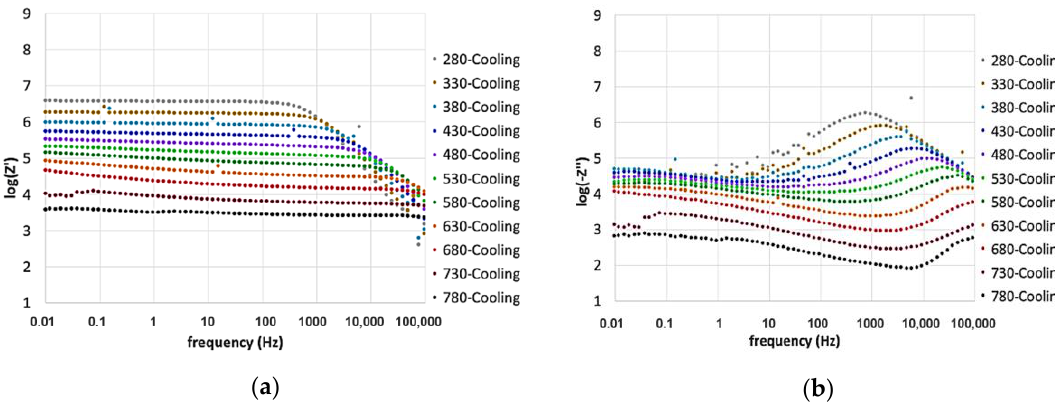
Figure 7. Frequency dependence of ( a ) the real part, Z’, and ( b ) the imaginary part, −Z’’, measured in the temperature range of 280–780 °C, during cooling.